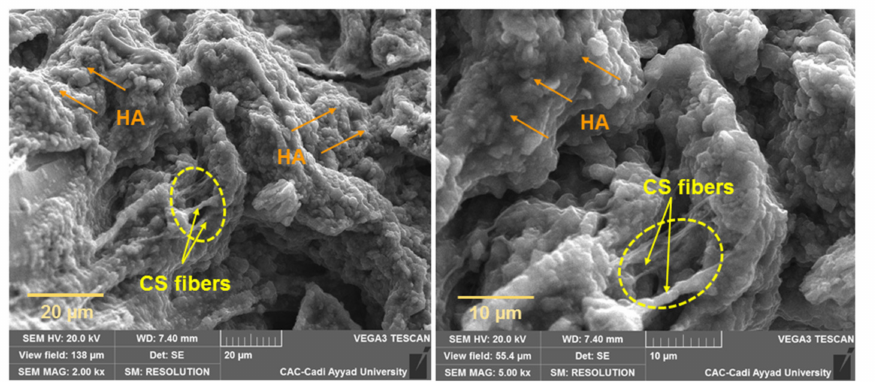
Figure 3. SEM images of the HA-CSM 5% composite (5 wt% of CSM) formulated at S/L of